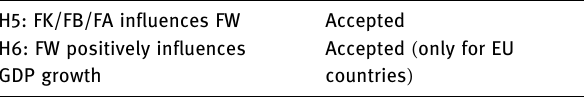
Table 11: Results of H5 and H6